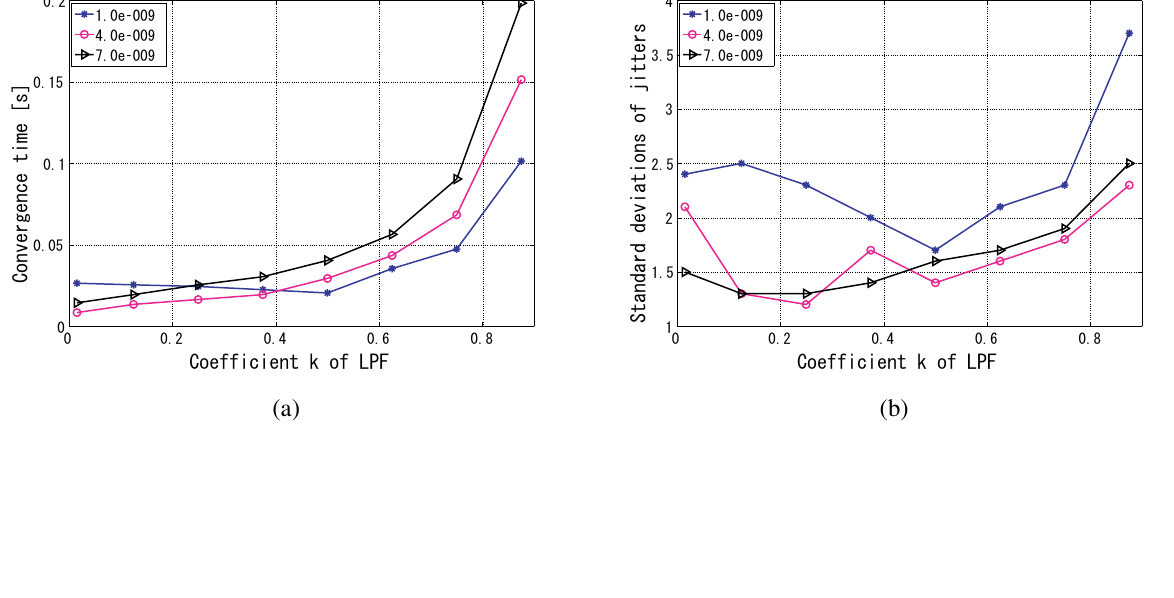
Figure 12. Analysis of the coefficient k of the IIR LPF, (a) convergence time versus different coefficient k of the LPF, (b) phase jitters versus different coefficient k of the LPF.